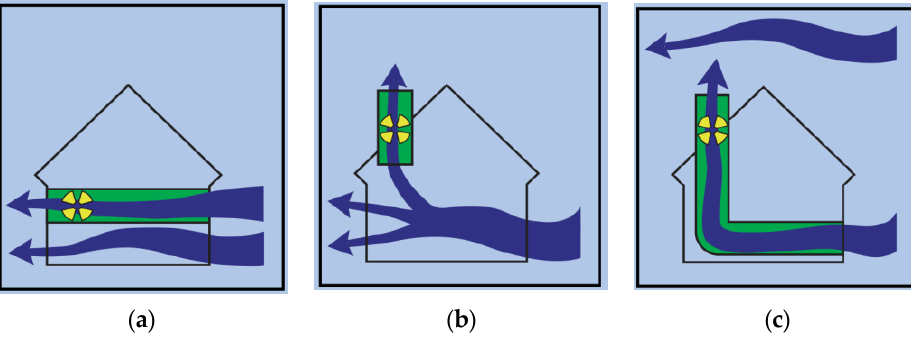
Figure 1. Types of Hybrid ventilation (Annex 35). ( a ) Natural and mechanical ventilation. ( b ) Fan-assisted ventilation. ( c ) Stack and wind-assisted mechanical ventilation.